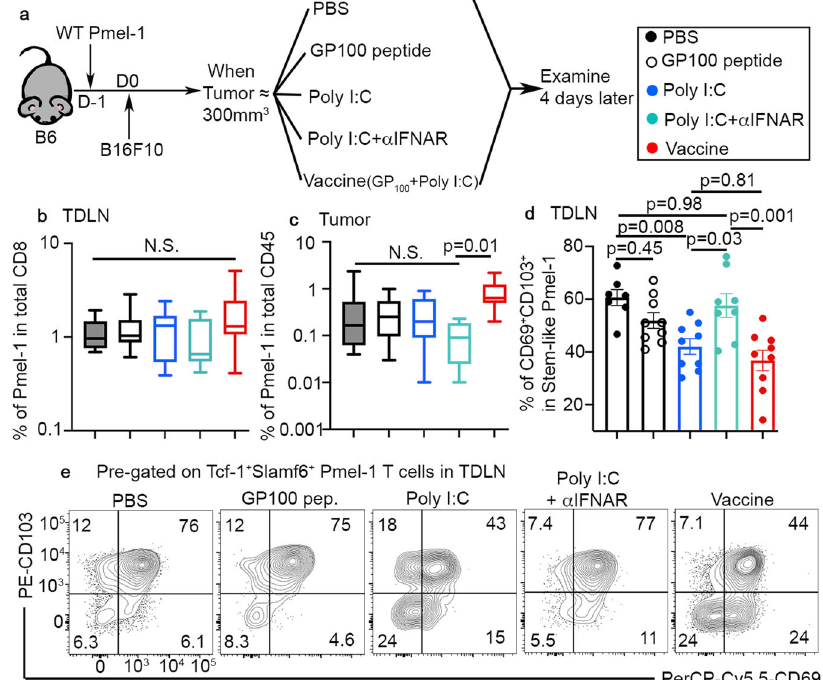
Fig.8|LossofTRMphenotypeinTDLNstem-likeTcellsislargelyduetotypeI IFN-dependent adjuvant effects. a Experimental design. Filled black, PBS; empty black, peptide; blue, poly I:C; aqua, poly I:C+aIFNAR; and red, vaccine. b The percentage of donor Pmel-1 T cells in total TDLN CD8 are shown (PBS, n =7, pep- tide, n =9, poly I:C, n =8, IFNAR blocking, n =7 and Vaccine, n =18). c The per- centage of donor Pmel-1 T cells in total CD45 + cells isolated from the tumor are shown(PBS, n =24,peptide, n =9,polyI:C, n =9,IFNARblocking, n =9andVaccine, n =13). d The percentage of CD69 + CD103 + cells in stem-like Pmel-1 T cells isolated